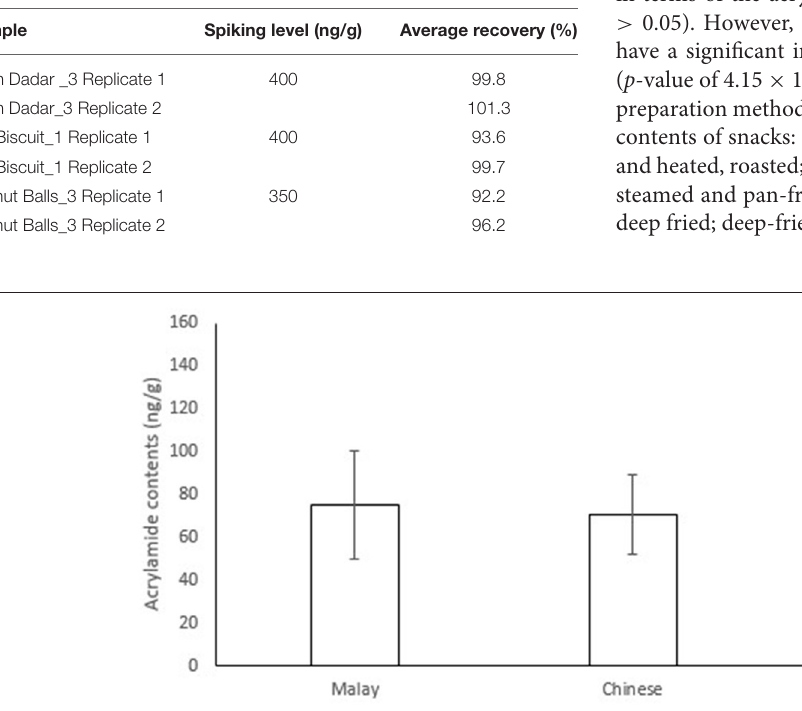
Frontiers in Nutrition |